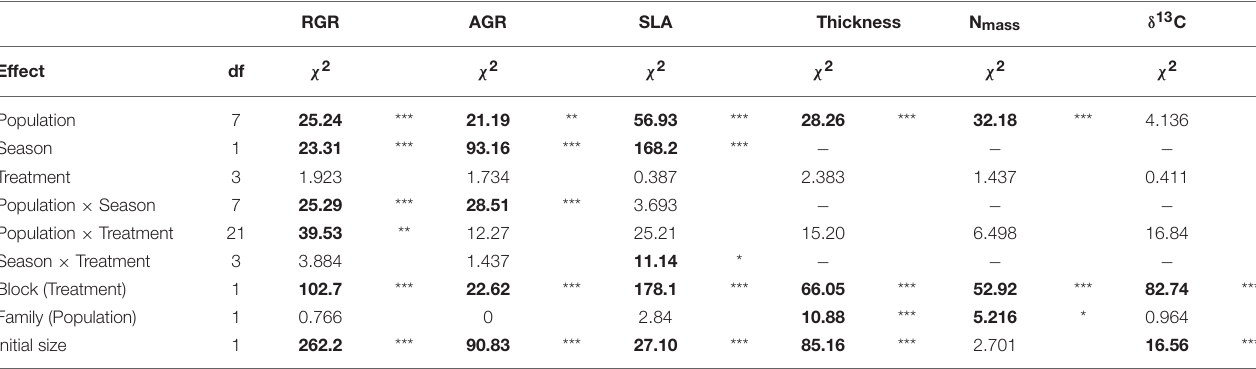
TABLE 3 | Mixed model results for area-based photosynthesis (A area ), mass-based photosynthesis (A mass ), area-based stomatal conductance (g s, area ), mass-based stomatal conductance (g s, mass ), instantaneous water use efficiency (WUEi). A area A mass g s, area g s, mass WUEi Effect df χ 2 χ 2 Population Treatment Population × Season Population × Treatment Season ×